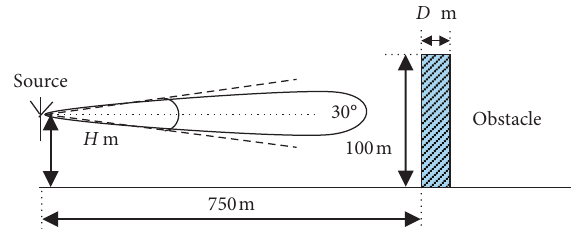
Figure 6: Simulation diagram of single rectangular